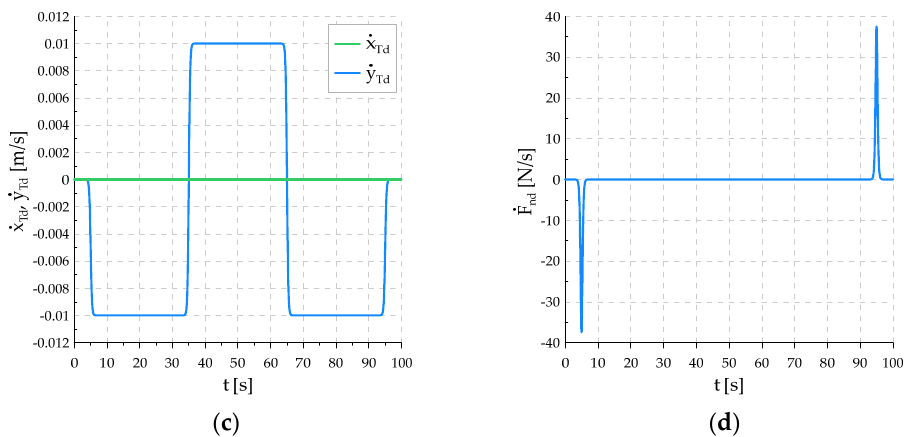
Figure 8. Graphs of set trajectory of control systems: ( a ) TCP coordinates on directions tangent to the surface of the workpiece; ( b ) downforce; ( c ) TCP velocity in tangent directions; ( d ) derivative of downforce.